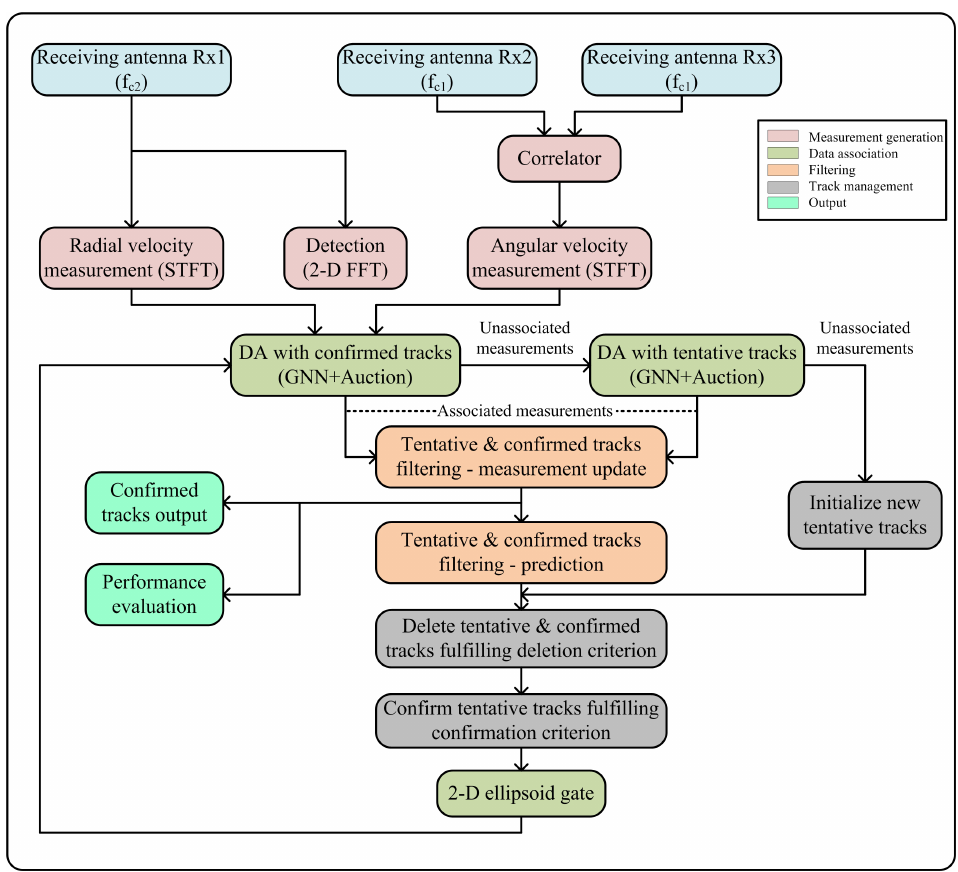
Figure 3. The block diagram of multi-target tracking algorithm based on 2-D velocity measure- ment